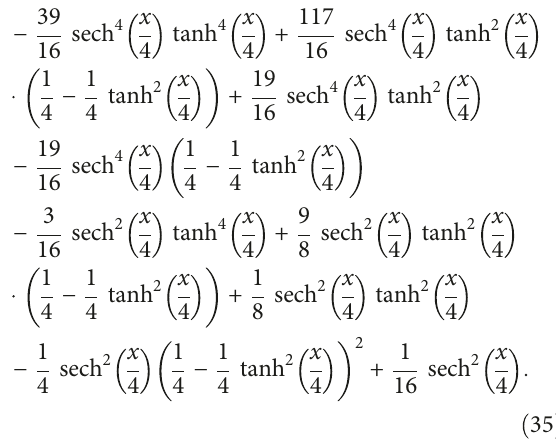
Figure 4, the di ff erent colors present di ff erent curves. In Figure 4(a), the parameter t is 0.01; in Figure 4(b), the param- eter t is